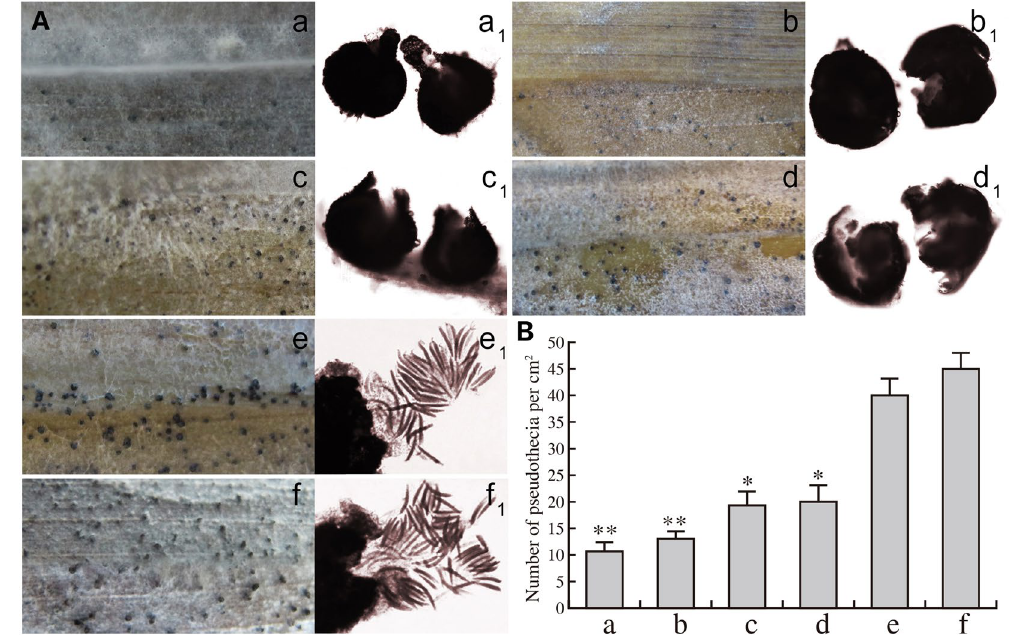
Figure 5. Effect of transformation of U. botrytis MAT genes on pseudothecia and asci formation in C. heterostrophus . ( A ) Pseudothecia formation in different cross or self matings on the surface of corn leaf substrates. ( B ) Average number of pseudothecia per square centimeter on the area of the corn leaf. Error bars indicate 95% confidence intervals. No significant differences were observed in the number of pseudothecia between W1 and W2 ( P > 0.05). a and a 1 Cross mating of Ch Δ mat0 { UbMAT } -2 × Ch Δ mat0 { UbMAT } -3 . b and b 1 Self mating of Ch Δ mat0 { UbMAT }- 4 . A few, tiny pigmented pseudothecia were discovered in a and a 1 or b and b 1 . c and c 1 Cross mating of C. heterostrophus C5 × Ch Δ mat0 { UbMAT }- 3 . d and d 1 cross mating of C. heterostrophus C4 × Ch Δ mat0 { UbMAT }- 2 . A medium number of slightly large pigmented pseudothecia were discovered in c and c 1 or d and d 1 . e and e 1 Cross mating of C. heterostrophus C5 × C. heterostrophus C4 ( W1 ). f and